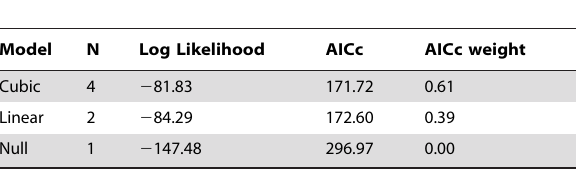
Table 2. Comparison between the null, linear and cubic